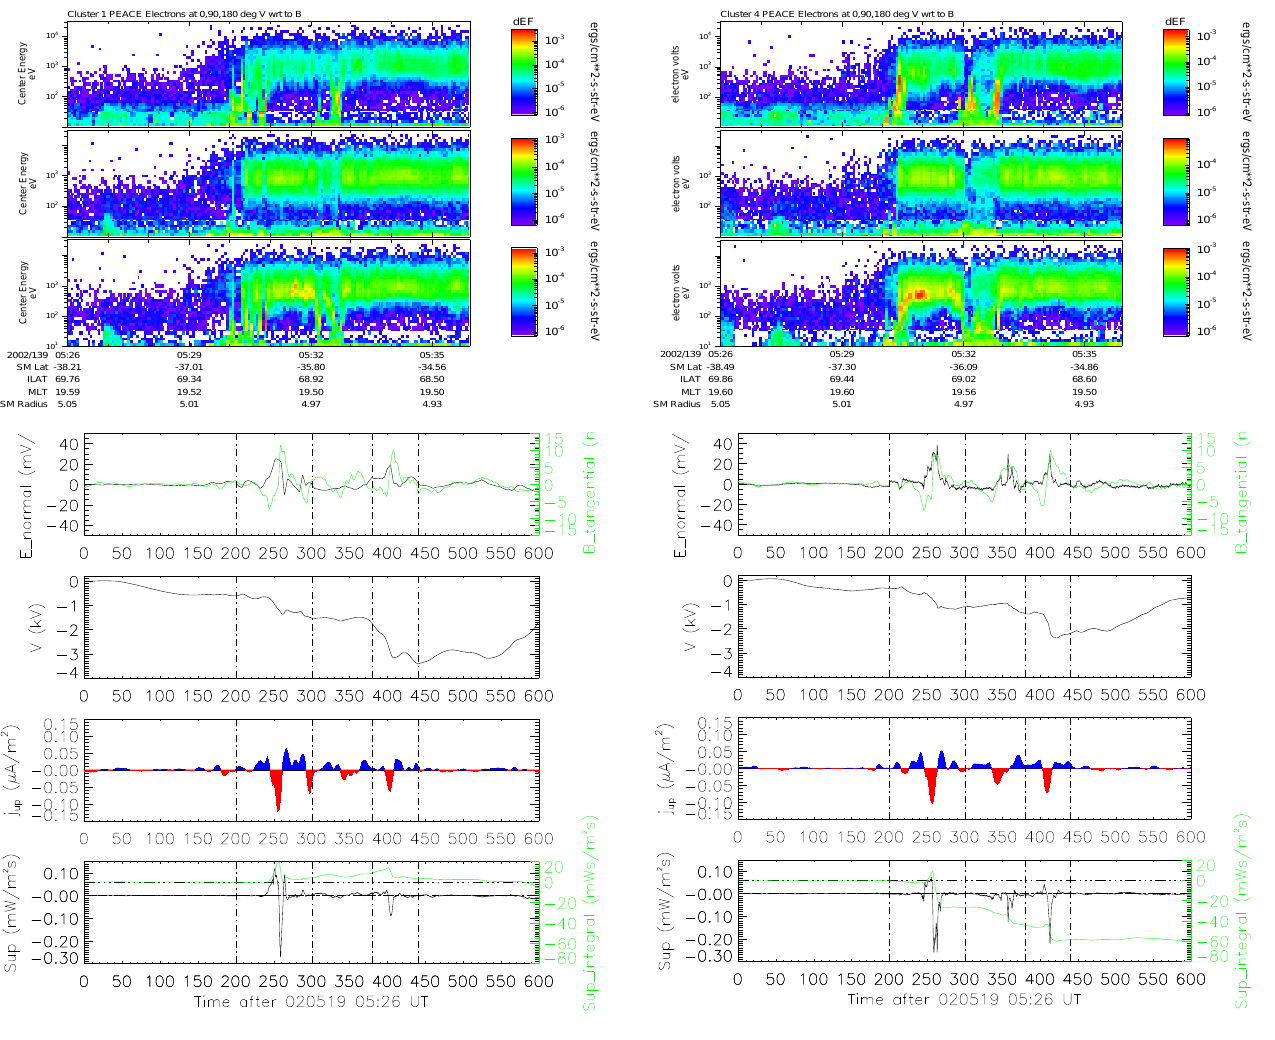
Fig. 2. 19 May 2002, s/c 1. Electron energy-time spectrograms at pitch angles 0, 90 and 180 ◦ are shown in the first three panels. This event is on the Southern Hemisphere, hence the first panel shows electrons going upward from Earth and the downward electrons are seen in the third spectrogram panel. The following panel shows the component of the electric field normal to the current sheet (black line) and the tangential component of the magnetic field (green line). Only these two components are shown, since they are the ones where the dominating variations are seen. The next panel displays the potential along the spacecraft trajectory. A negative (positive) value in the second to last panel corresponds to downward (upward) FACs and is shown with red (blue) color. Poynting flux (black line) and the integrated Poynting flux (green line) are plotted in the bot- tom panel. The vertical dash-dot lines delimit the regions of domi- nating spatial and temporal variations (see the text). All panels are local value plots, with the ionospheric mapping factors being 11.2 for E and 125 for FAC and S.